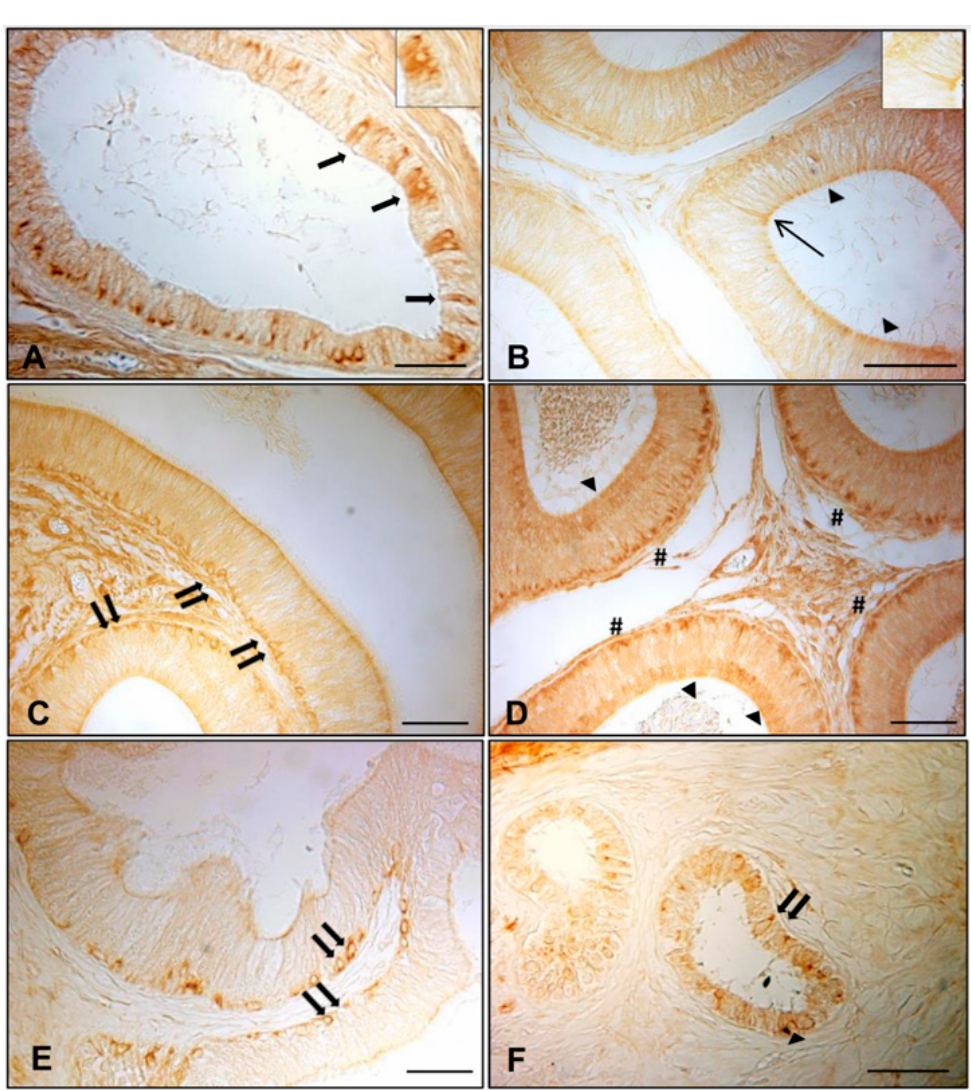
Figure 1. Immunohistochemical staining of AQP7 in normal and cryptorchid efferent ductules and epidydimal segments. In the normal dogs, AQP7 was distributed in ( A ) the epithelium lining the efferent ductules (arrows), ( B , D ) the apical portion of the principal cells of caput and cauda (arrowheads), ( D ) the basal portion of the cauda (pounds), and ( B ) in some narrow cells of the caput (line arrow). ( C , E , F ) Positive basal cells were observed in the corpus of the normal epididymis and in the caput and cauda of the cryptorchid epididymis (double arrows). Bar: 25 micron.